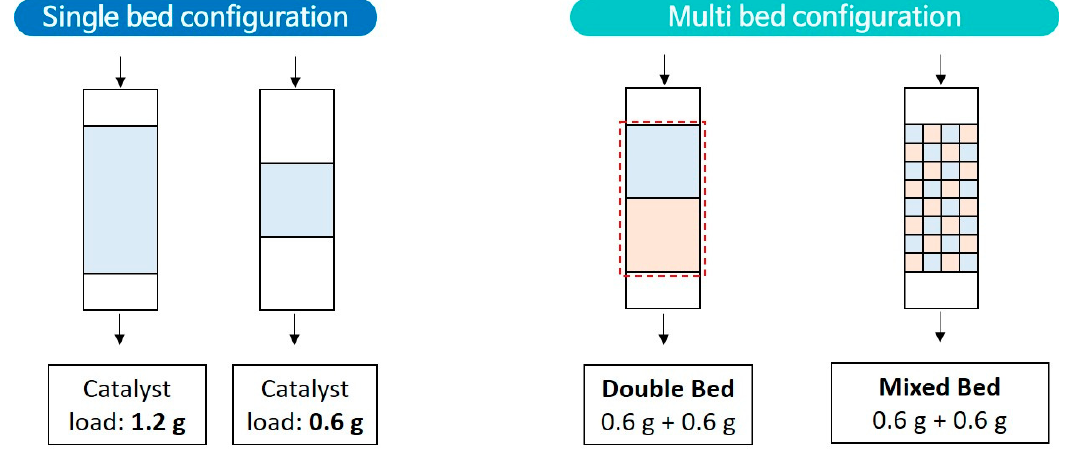
Figure 7. Catalyst bed configurations.